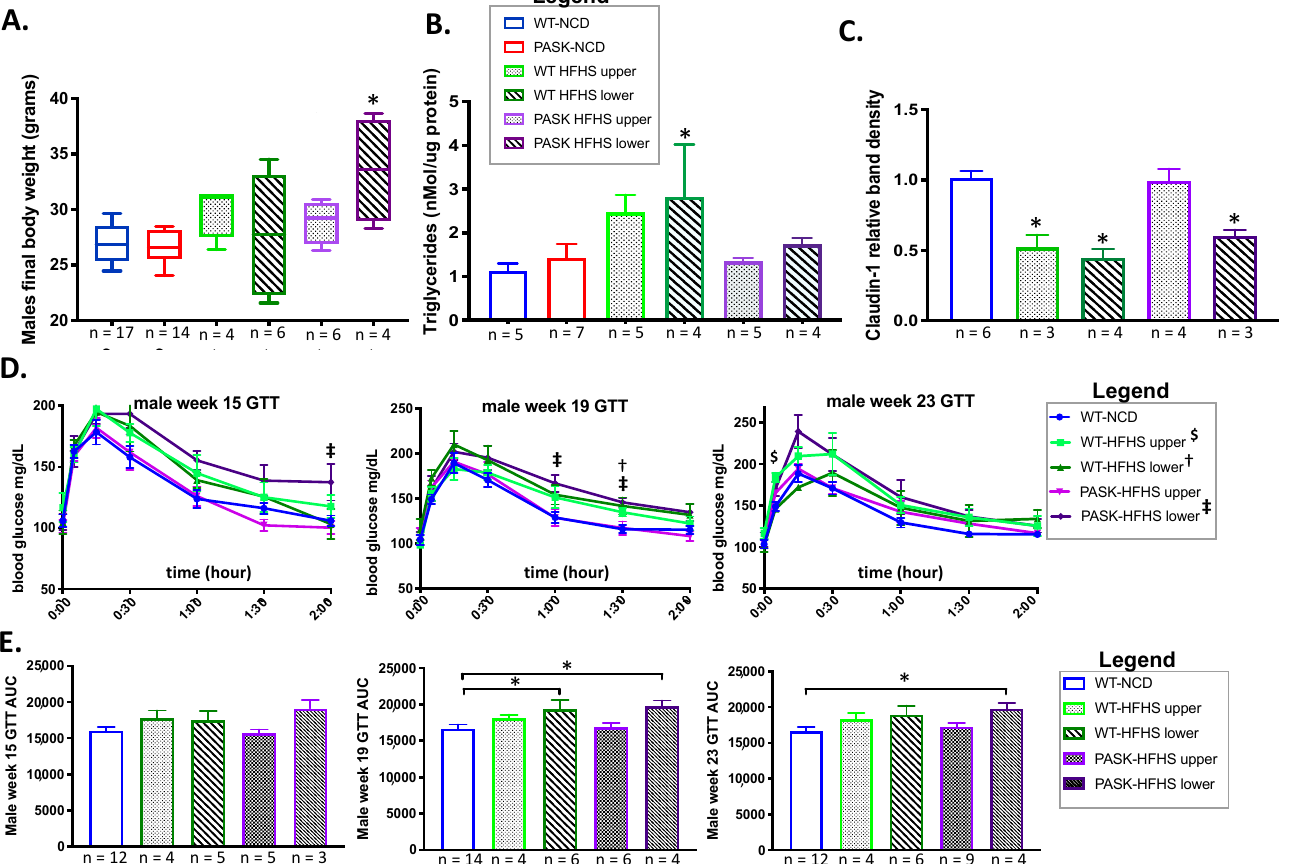
Figure 7. An interplay between genotype and microbial composition influences weight and glucose response. ( A ) Comparison of weight gain, ( B ) triglyceride accumulation, and ( C ) claudin-1 expression on the high-fat high-sugar diet by unweighted UniFrac PCoA cluster and genotype with sample number provided on the x-axis. ( D ) Glucose tolerance (GTT) tests at week 15, 19 and 23. ( E ) Area under the curve (AUC) of the GTT’s shown in ( D ), with sample number provided on the x-axis. ANOVA followed by post hoc Dunnett’s analysis using WT-NCD as control was performed on all samples, including individual GTT time points (symbols †, ‡, $ for p < 0.051) as well as the AUC (* is used for p < 0.051) using JMP Pro version 14.